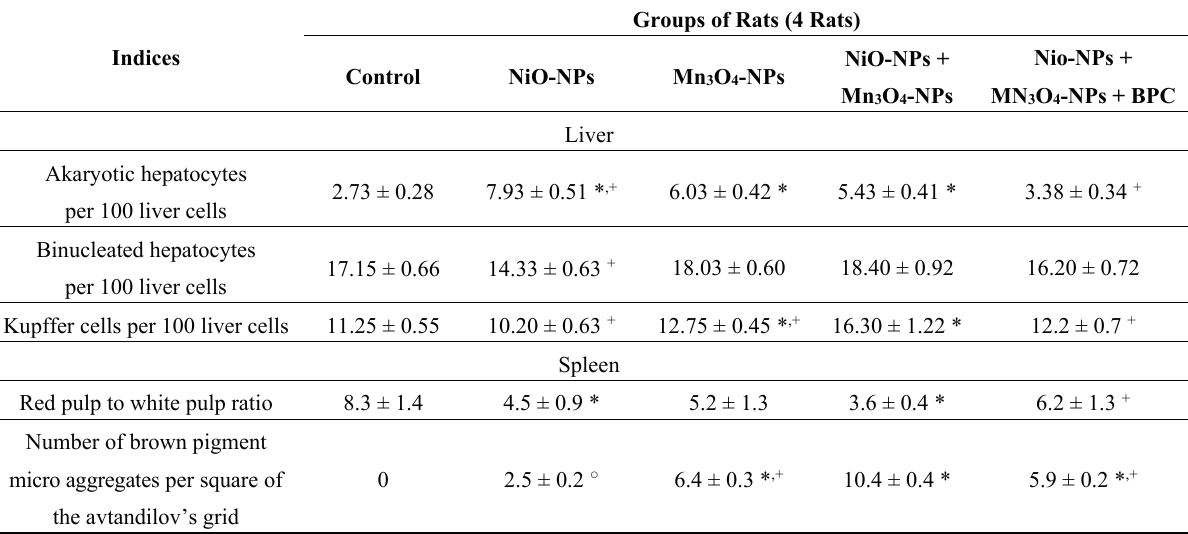
Table 5. Morphometric indices for the state of rat’s liver and spleen after repeated intraperitoneal injections of NiO or Mn 3 O 4 nanoparticles, together or separately, and of their combination with background oral administration of the BPC (X ± s.e.).